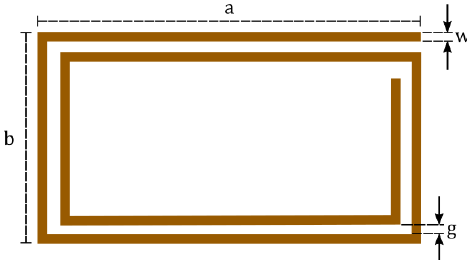
Figure 2. Two-turn rectangular coil with its dimensional parameters.